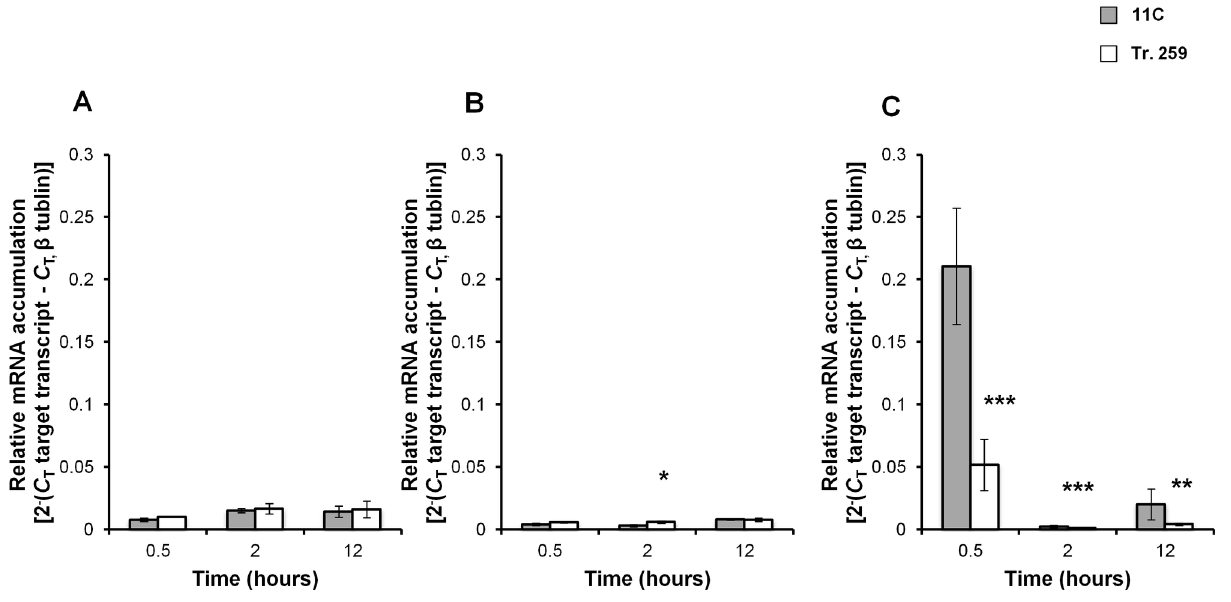
Figure 5. RT-PCR analysis of putative hexose transporter under alcohol stress. Temporal analysis of putative hexose transporter transcript (FOXG_09625) during shake flask growth of Fusarium oxysporum strain 11C and transformant Tr. 259 under normal conditions ( A ), ethanol stress ( B ) and butanol stress ( C ). F . oxysporum (2ml 10 6 ml -1 ) was aerobically cultured in Erlenmeyer flasks (100 ml) in 48 ml of minimal medium [37] for 12 hours shaking at 150 rpm at 25°C. At 12 hours, flasks were amended with 2ml of water, ethanol or butanol to a final concentration of 0%, 4% and 0.75% (vv -1 ), respectively. RT-PCR was conducted on RNA samples harvested at 0.5, 2, 12 hours respectively post – inoculation. Putative HXT accumulation was quantified relative to the housekeeping gene β-tubulin (FOXG_06228) [38] Results are based on three experiments (no alcohol, ethanol) or two experiments (butanol), each with three replicates per time point per strain tested. RT-PCR was conducted twice on each experiment. Bars indicate SEM. Tr. 259 FOXG_09625 mRNA accumulation significantly different from strain 11C is highlighted with an asterisk (level of significance: *<0.05, **≤ 0.01, ***< 0.001). doi: